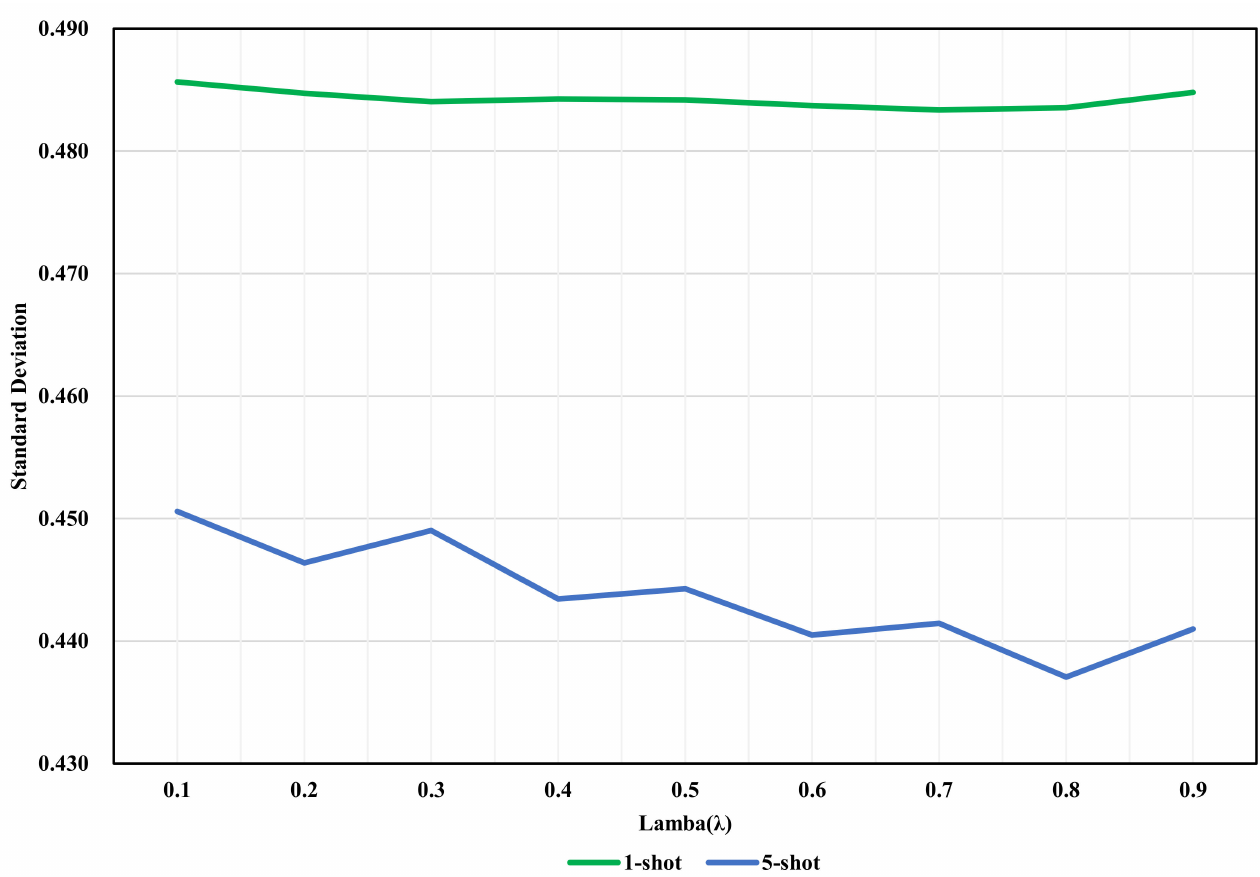
Figure 8. The standard deviation of model’s performance with different settings of hyperparametric λ in 1-shot and 5-shot scenarios. The x -axis shows the different values of λ , and the y -axis shows the model’s standard deviation. The green curve represents the standard deviation of the 1-shot scenario. The model’s standard deviation decreases as λ increases, reaching a minimum with λ of 0.7. However, the standard deviation of the model’s accuracy starts to increase with an excessively large λ . The blue curve represents the standard deviation of the 5-shot scenario. Similarly, the model’s standard deviation decreases as λ increases, reaching a minimum with λ of 0.8. However, the standard deviation of the model’s accuracy starts to increase with an excessively large λ